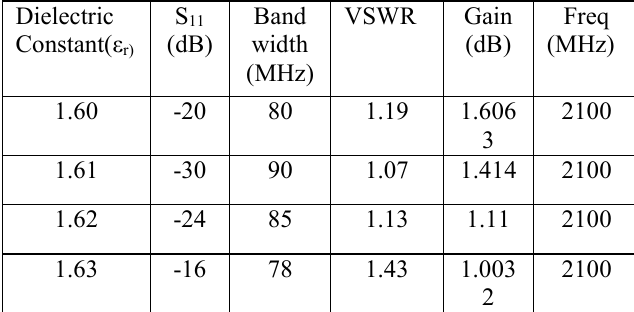
Fig.1.3 S 11 Response of the Antenna 1 Table 1.1 Analysis of different parameters for Antenna